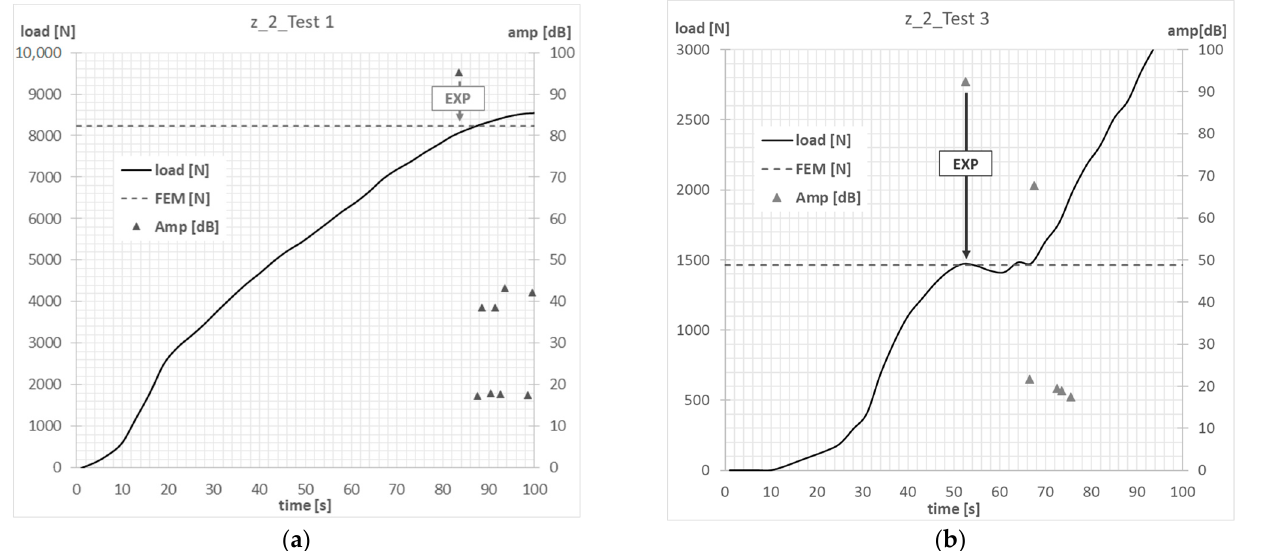
Figure 8. Column z_2—failure initiation force: ( a ) axial compression—Test 1; ( b ) eccentricity—Test 3.